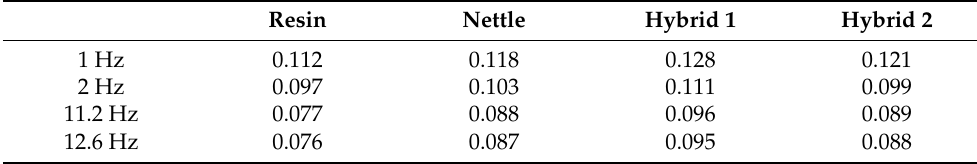
Table 3. Loss factors for typical vehicle natural damped